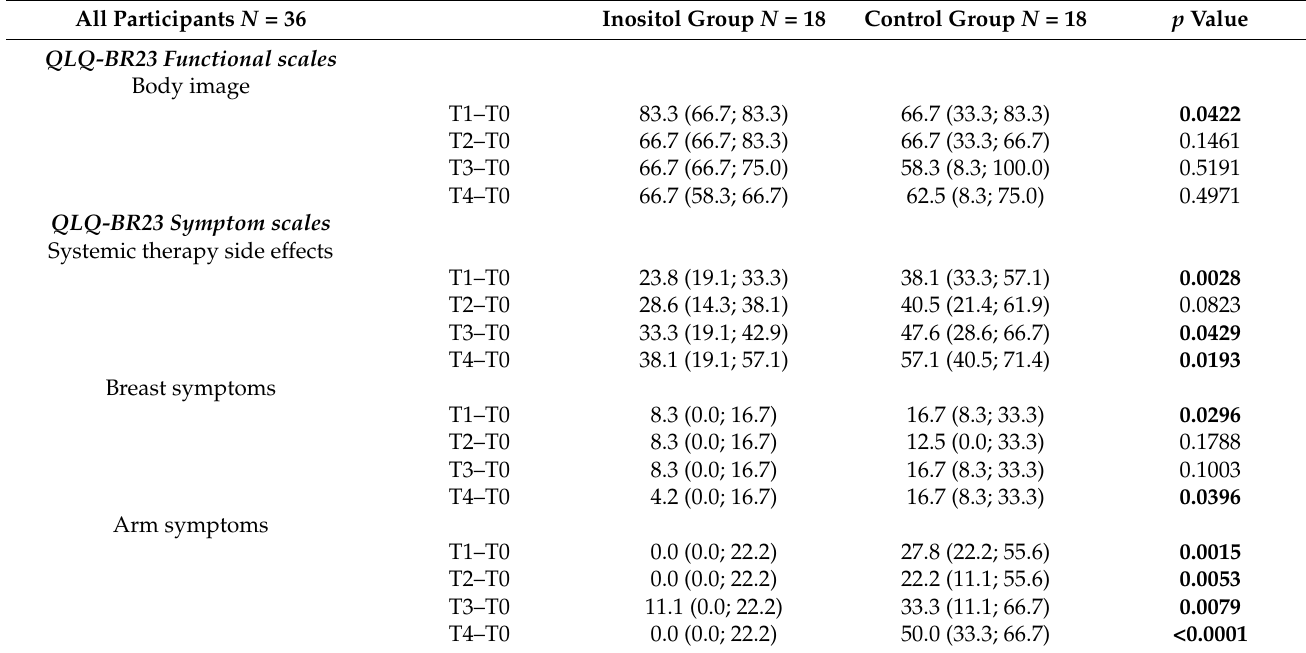
Table 4. Differences between the Inositol Group and the Control Group during the follow-up (T1-T4) in QLQ-BR23 questionnaire scores.